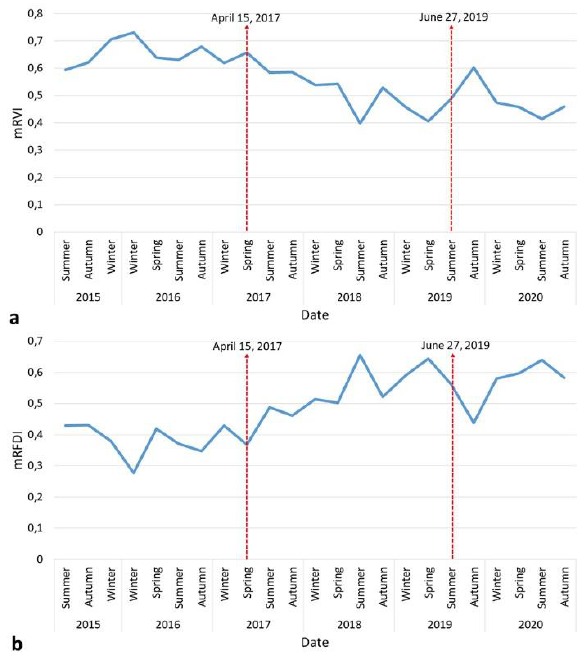
Figure 8. Sentinel-1 2015-2020 GEE seasonal average a) mRVI and b) mRFDI time series.